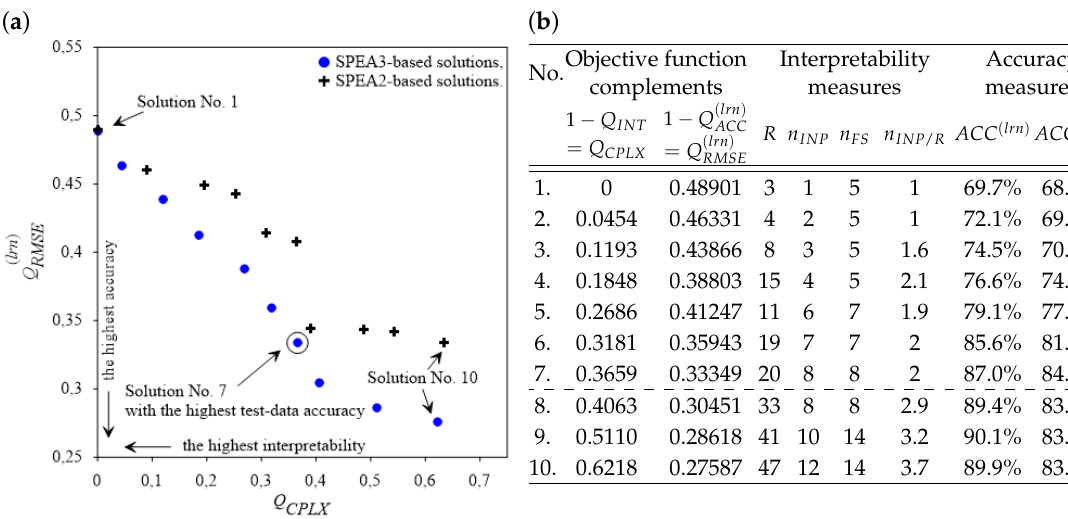
( a ) The best Pareto-front approximation generated by our SPEA3 and SPEA2; ( b ) interpretability and accuracy measures of SPEA3-based solutions from ( a ) ( Electrical Grid Stability Simulated Data Set